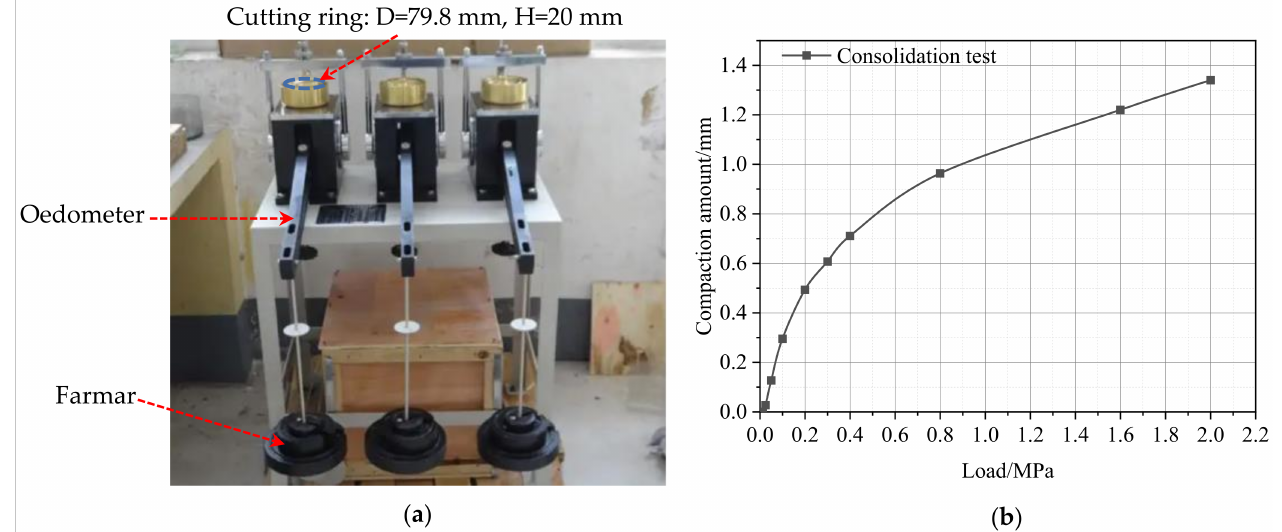
Figure 5. Physical consolidation test model and results; ( a ) Physical consolidation test model; ( b ) Physical consolidation test